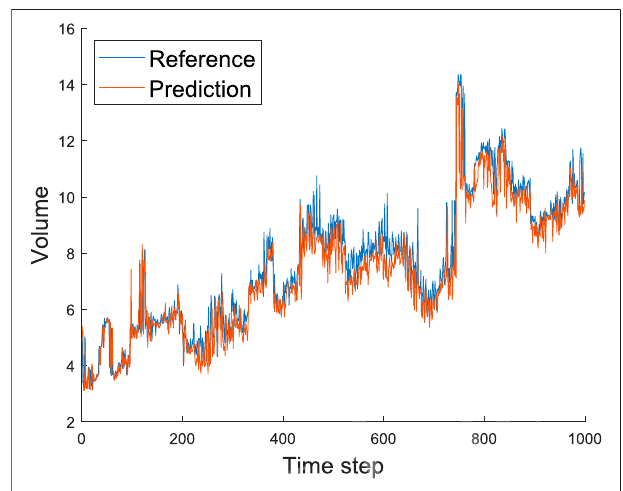
FIGURE 10 | Predicted and reference volume (scaled with h 3 ) of all the structures in the wake region ( y > 0.2) as a function of the time step. Note that the network rarely overestimates this